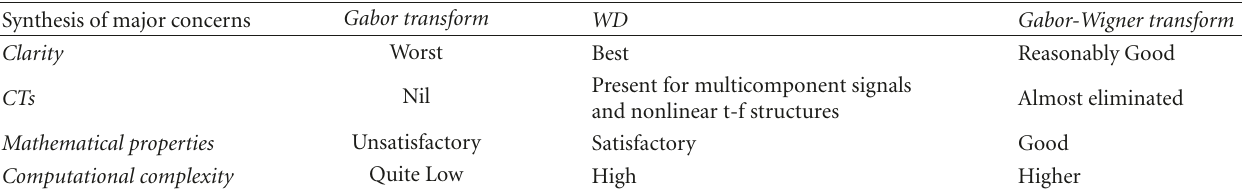
Table 1: Synthesis of main problems related to